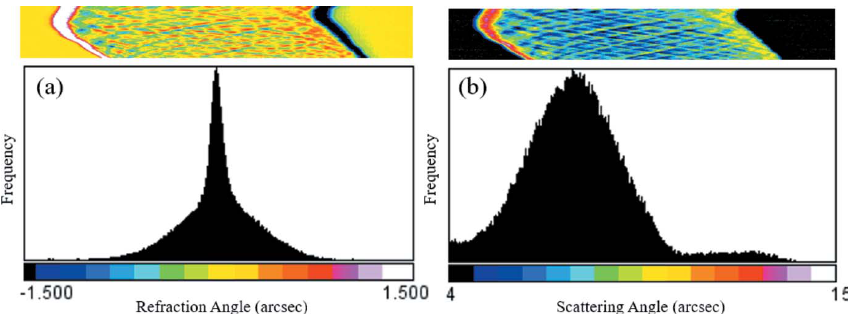
Figure 5 Sinograms (upper) and histograms (lower) of ( a ) the refraction angle, (cid:2) (cid:2) cm , and ( b ) the scattering angle, (cid:5) USAXS , obtained for M = 10.